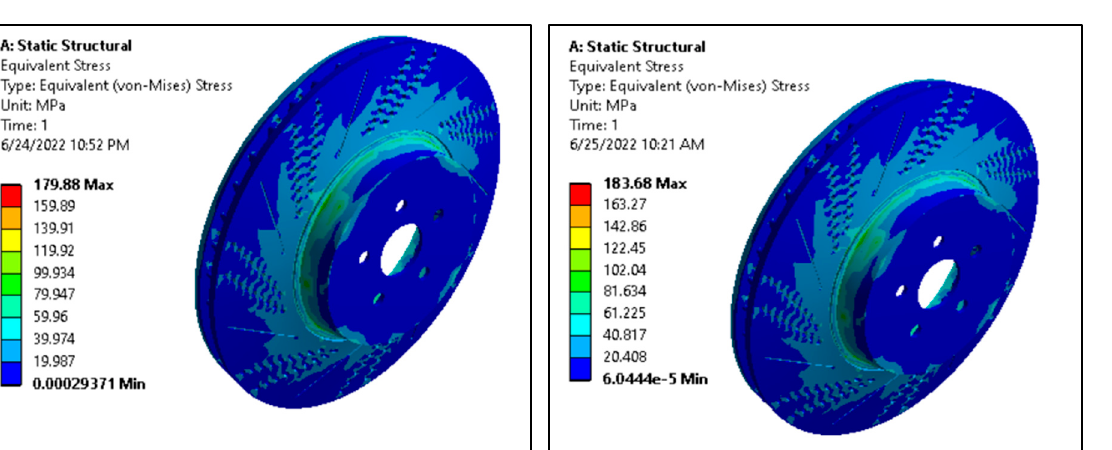
Figure 3. Boundary conditions for mechanical and thermal analysis.